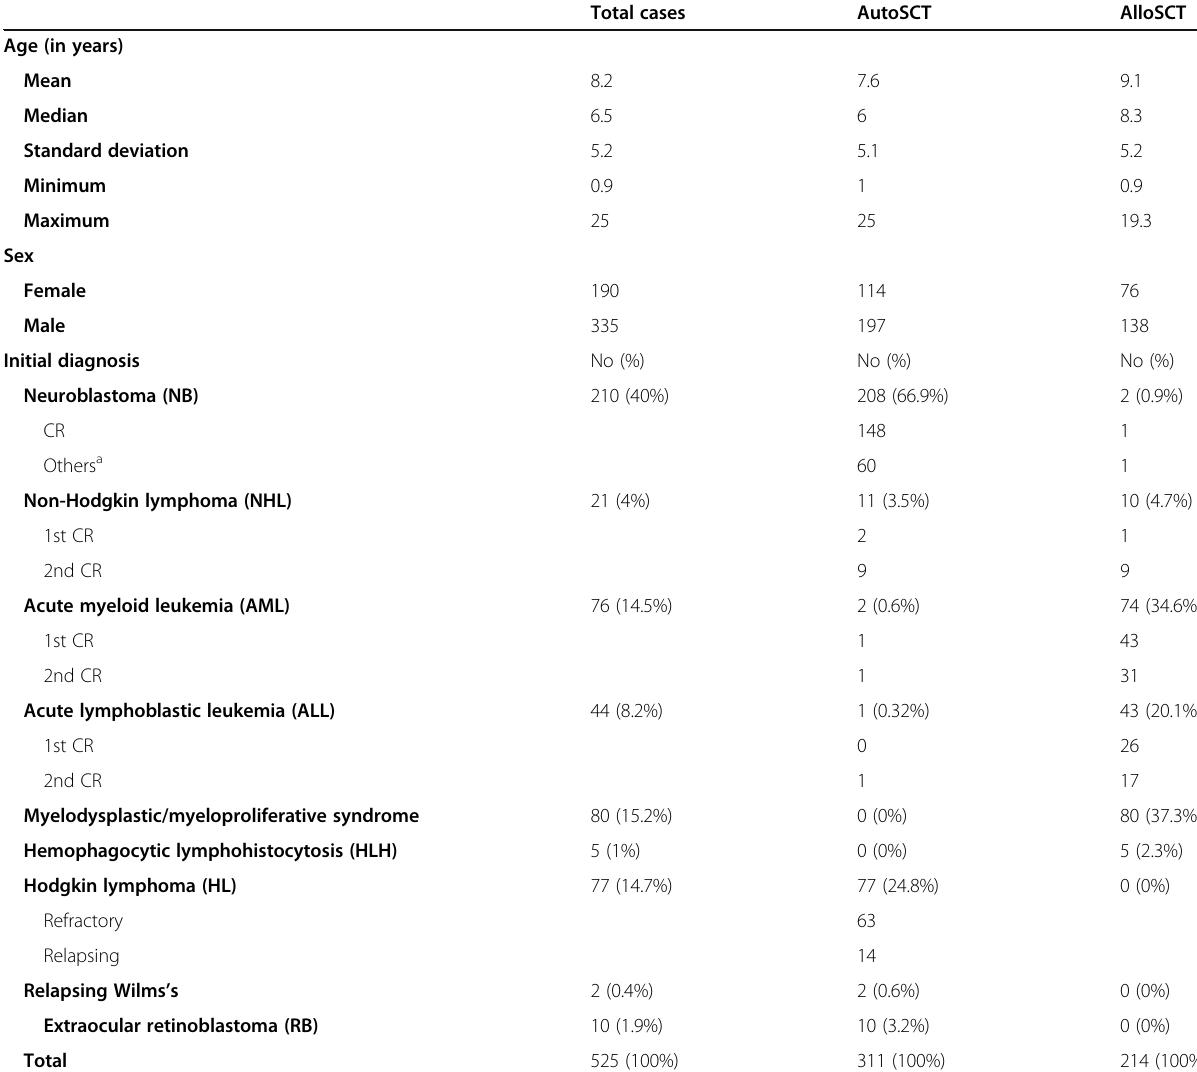
Table 1 Characteristics of HSCT patients